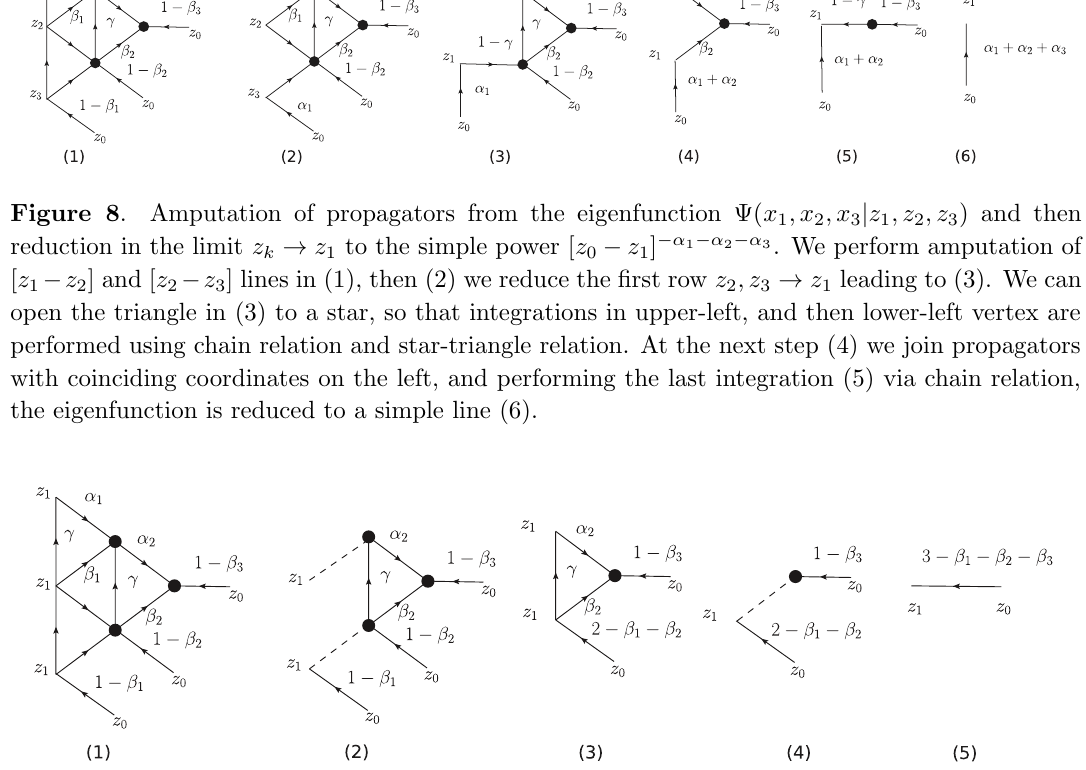
z 1 ; z 2 ; z 3 ) in the limit z k z 1 to simple j ! z 1 in !